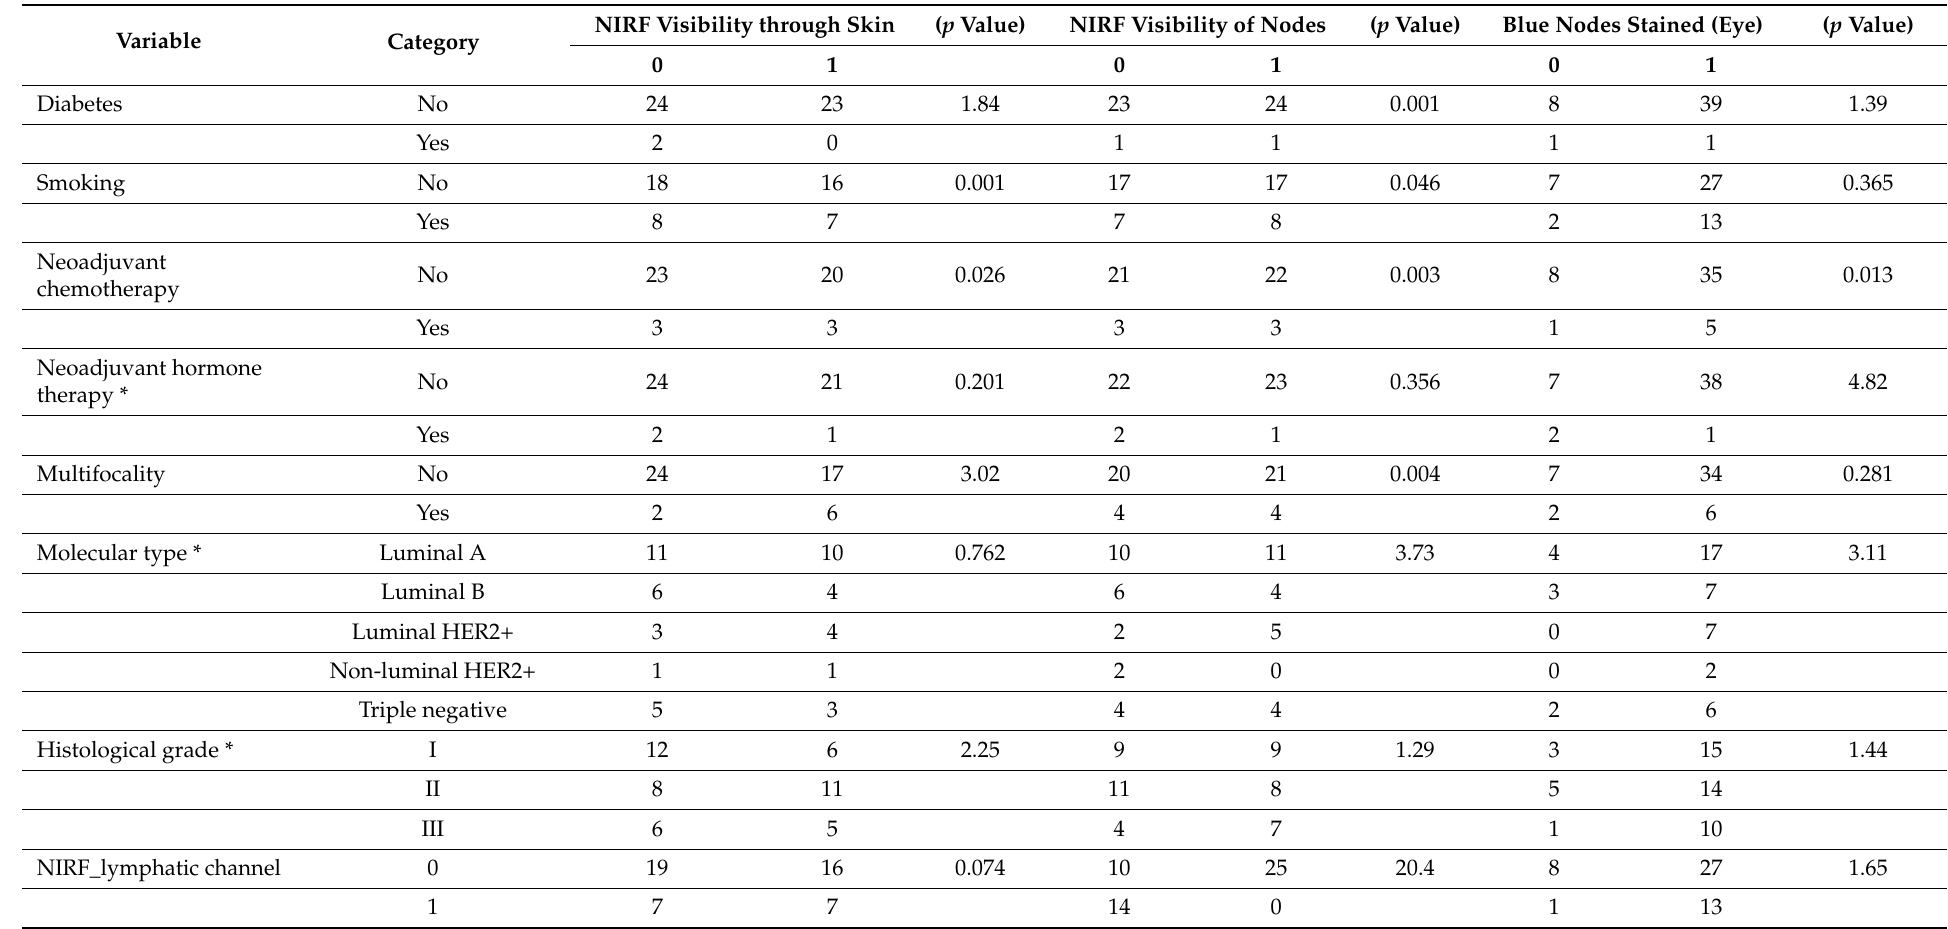
Table 3. Critical values of the Chi-Square test for factors associated with near-infrared fluorescence visibility through skin and of sentinel lymph nodes in comparison to naked eye visibility of blue-stained